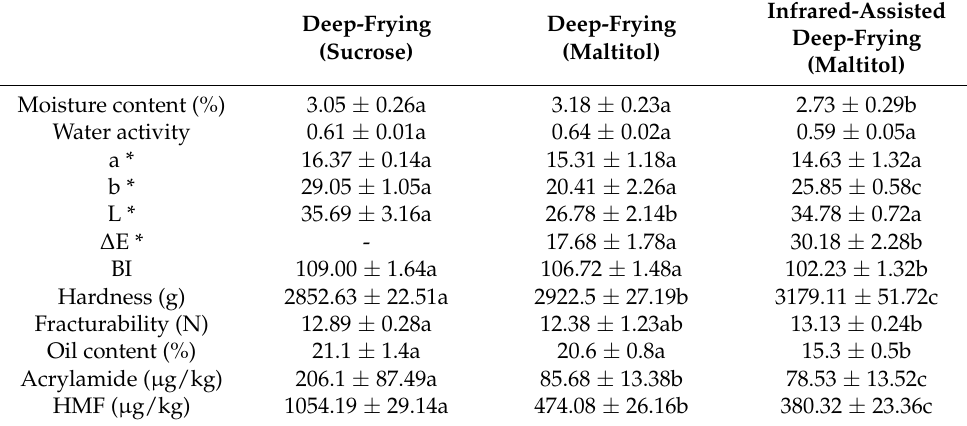
Table 4. Moisture content, water activity, color parameter, texture parameters, acrylamide con- tent, 5-(hydroxymethyl)-2-furfural (HMF) content, and oil content in the deep-frying and infrared pretreatment deep-frying fried dough twist (FDT).